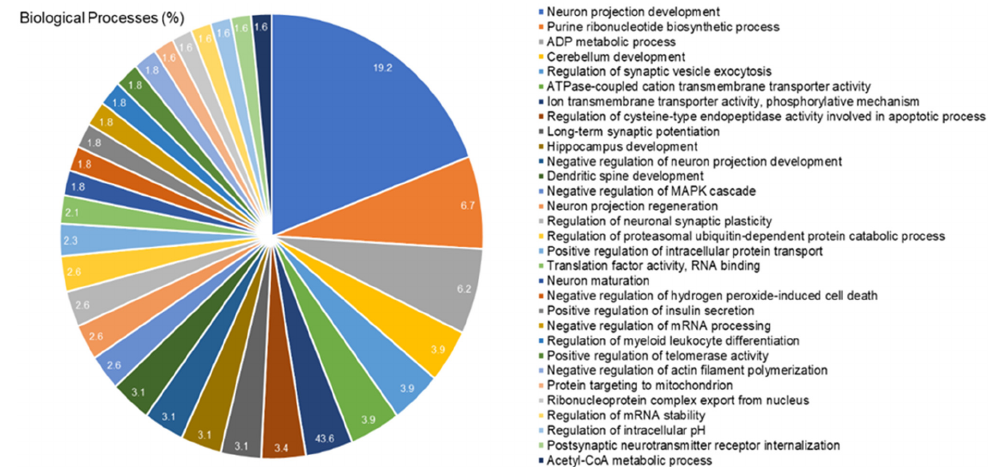
Table 1. Identified proteins with expression significantly altered in the cerebellum of rats of the IHg group versus control group.